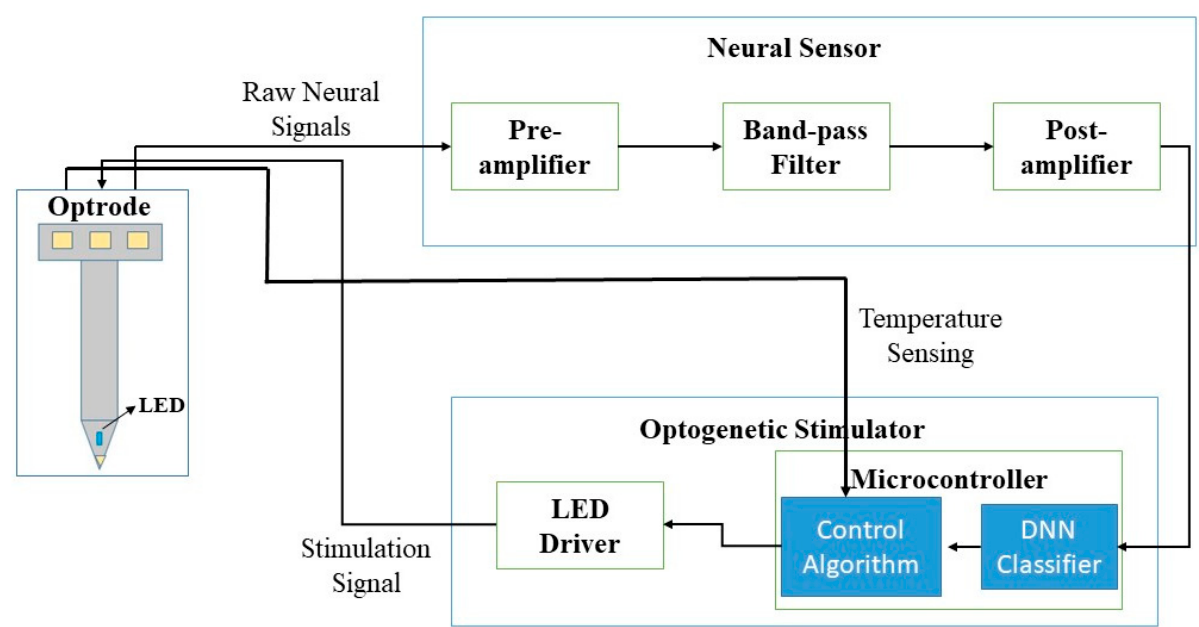
Figure 1. Block diagram of the proposed clOBS device.